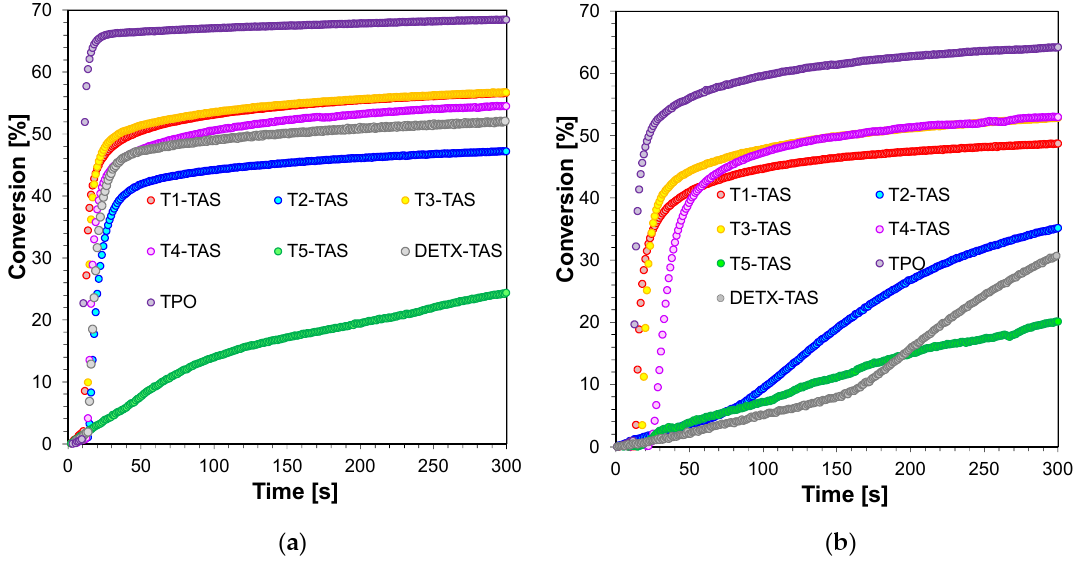
Figure 4. Polymerisation profiles of trimethylolpropane triacrylate (TMPTA) (acrylate function conversion vs. irradiation time in laminate in the presence of different photoinitiating systems based on TAS (2% w / w ) and 2,4-diethyl-thioxanthen-9-one derivatives (0.2% w / w ) upon exposure to ( a ) the visible LED@405 nm ( b ) the visible LED@420 nm. The irradiation starts at t = 10 s.